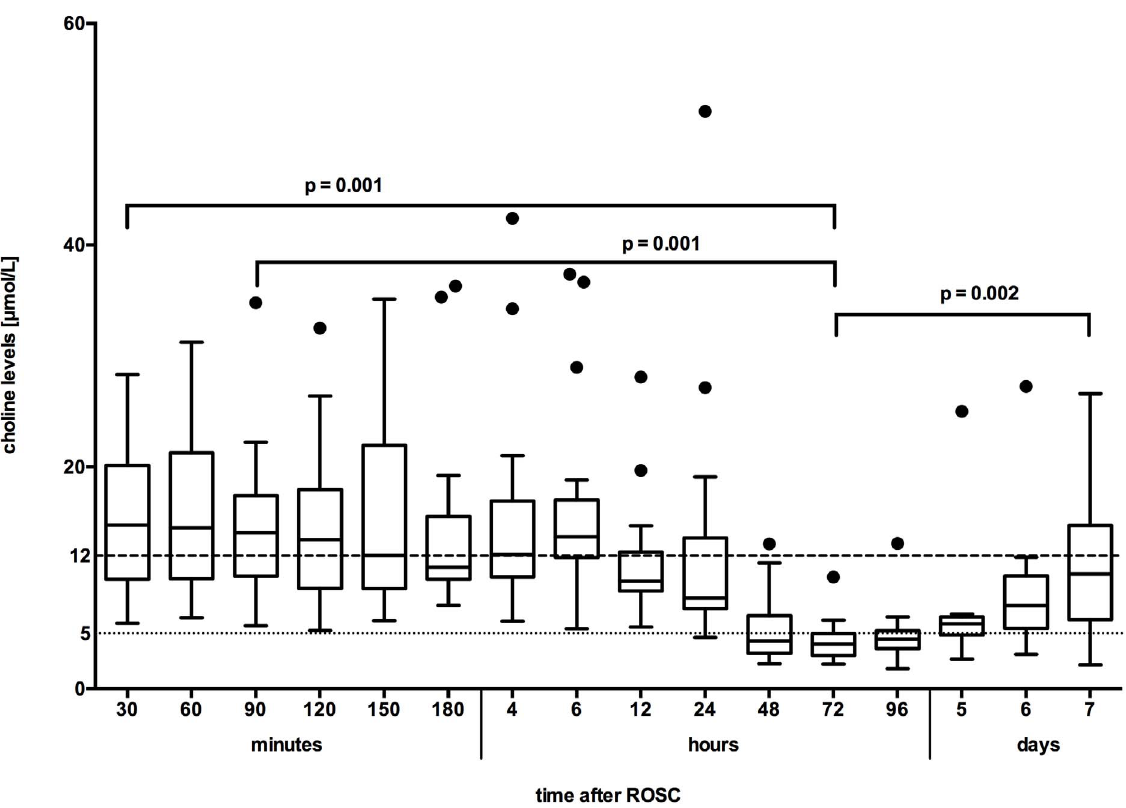
Figure 1. Plasma free choline concentration throughout the study. Dotted line: lower limit reference range; dashed line: upper limit reference range.